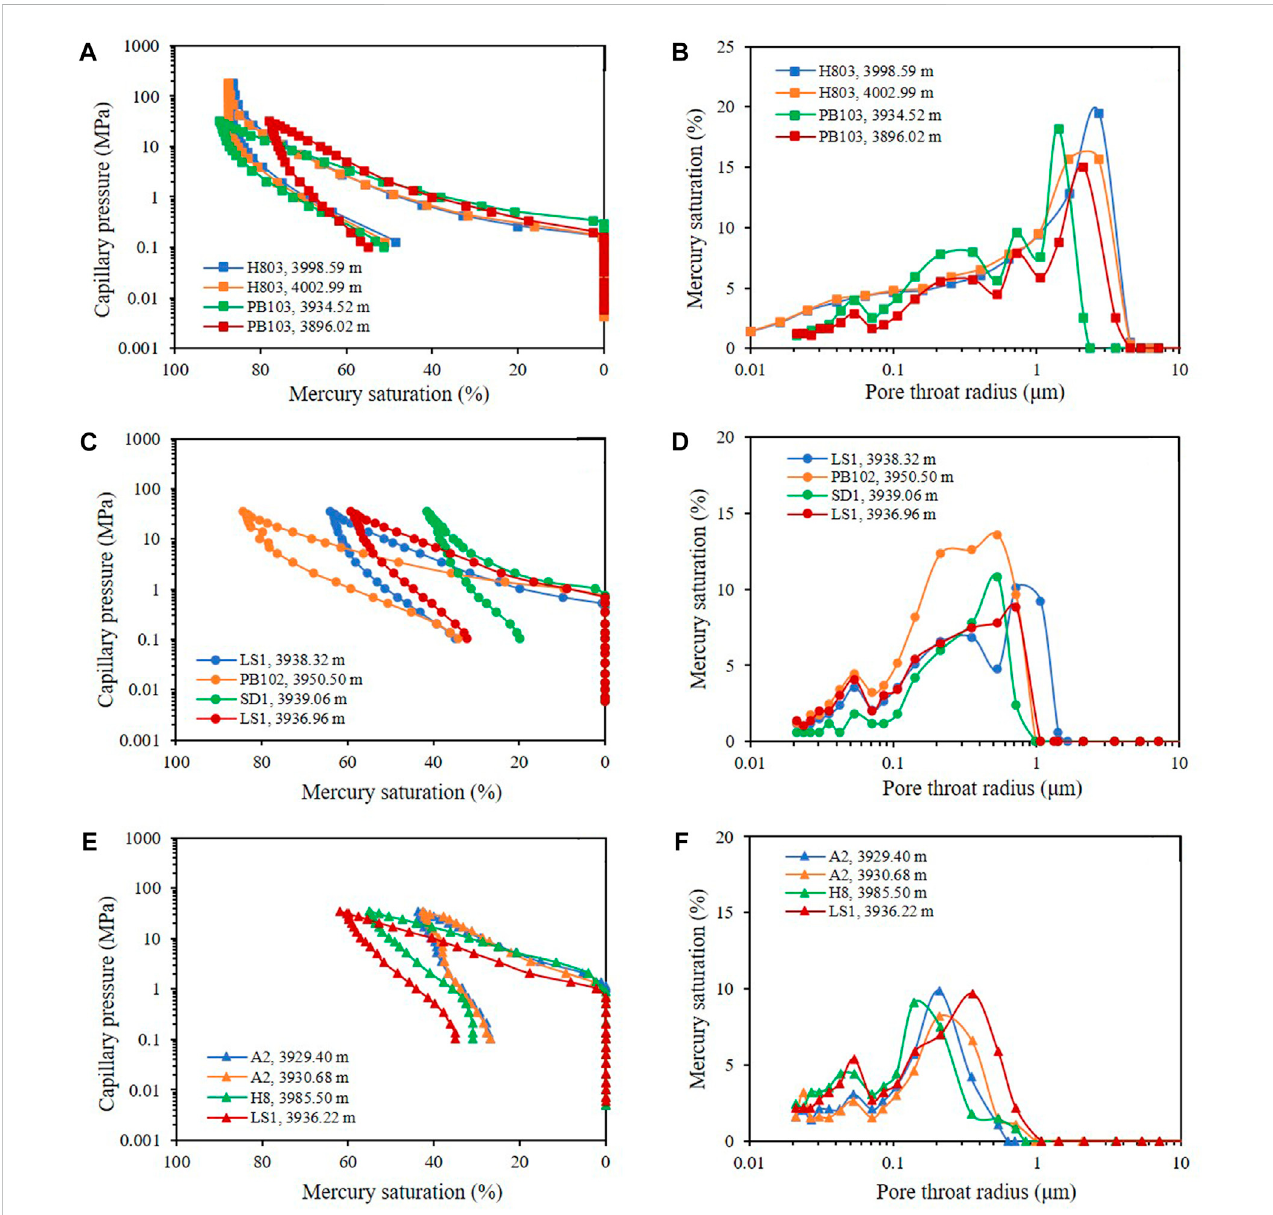
FIGURE 5 MICP curves (A, C, E) and corresponding pore-throat size distributions (B, D, F) of different types of sandstones in theTaibei Sag. (A, B) -AHP sandstones. (C, D) -NHP sandstones. (E, F) -NLP sandstones.